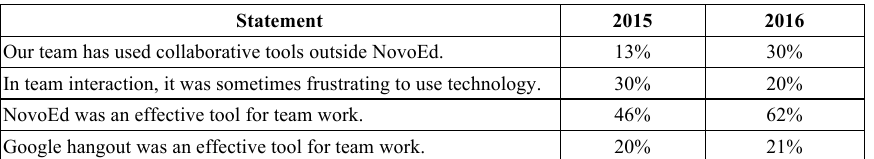
Table 2. Effective collaboration